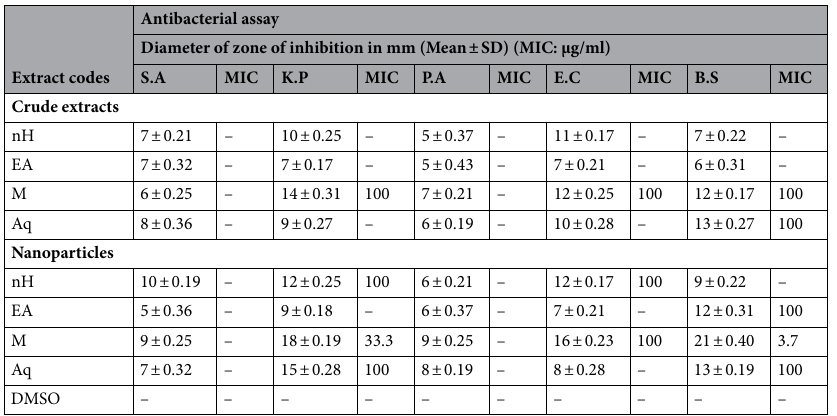
Table 2. Antibacterial activity and MIC values of F. cretica crude extracts and ZnO NPs. * The sample concentration was 100 µg per disc. Values (mean ± SD) are average of triplicate analysis of each plant extract (n value of 1 × 3). – = No activity. Samples showing zone of inhibition ≤ 12 mm were not proceeded for MIC determination. . S.A = Staphylococcus aureus , B.S = Bacillus subtilis , P.A = Pseudomonas aeruginosa , K. P = Klebsiella pneumoniae , E.C = Escherichia coli. . Positive control = Cef: Cefaxime, Rox: Roxithromycin. –- = no activity.